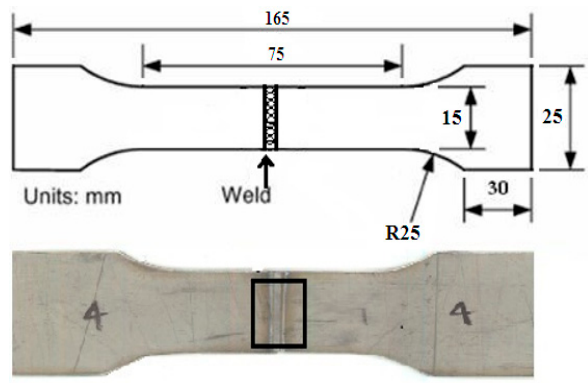
Figure 9. Tensile weld specimen dimension.